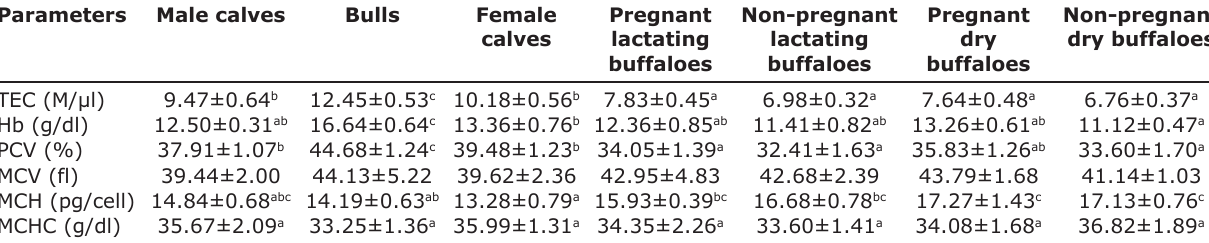
Table-1: Erythrocytic indices of different experimental groups of Banni buffaloes. Parameters Male calves